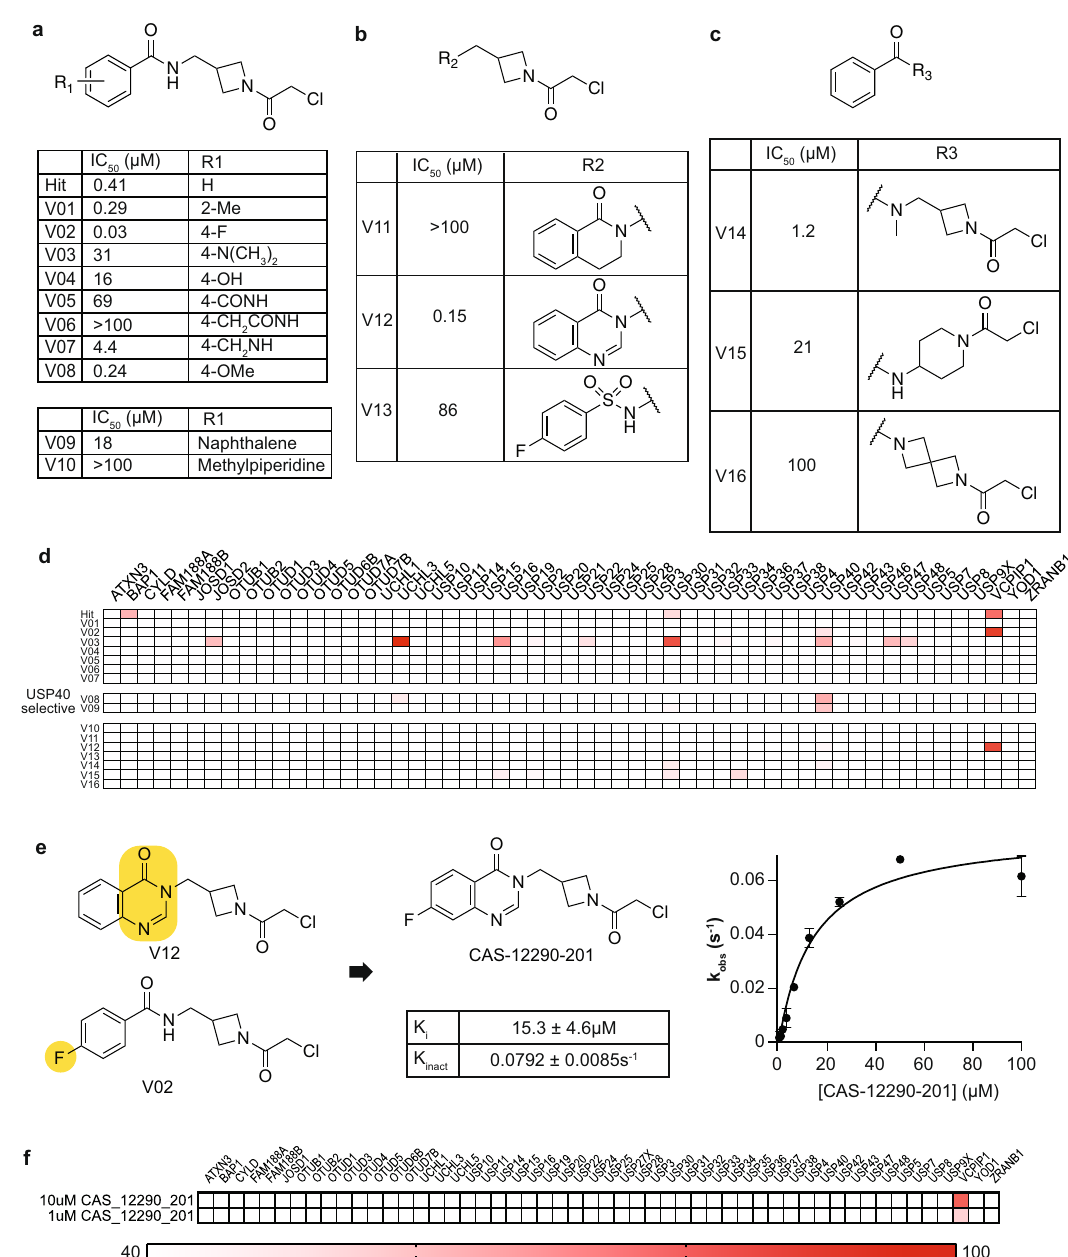
Fig. 6 | Optimization of a potent and selective VCPIP1 inhibitor. a – c Structures and VCPIP1 biochemical inhibitory activity of WH-9943-103C analogs. Data for hit WH-9943-103C are duplicated from earlier fi gures for ease of comparison. d DUB- ABPP data for the WH-103C focused library. Compounds with VCPIP1 biochemical IC 50 values below 250 nM (V02, V08, V12) were screened in ABPP at 10 μ M, less